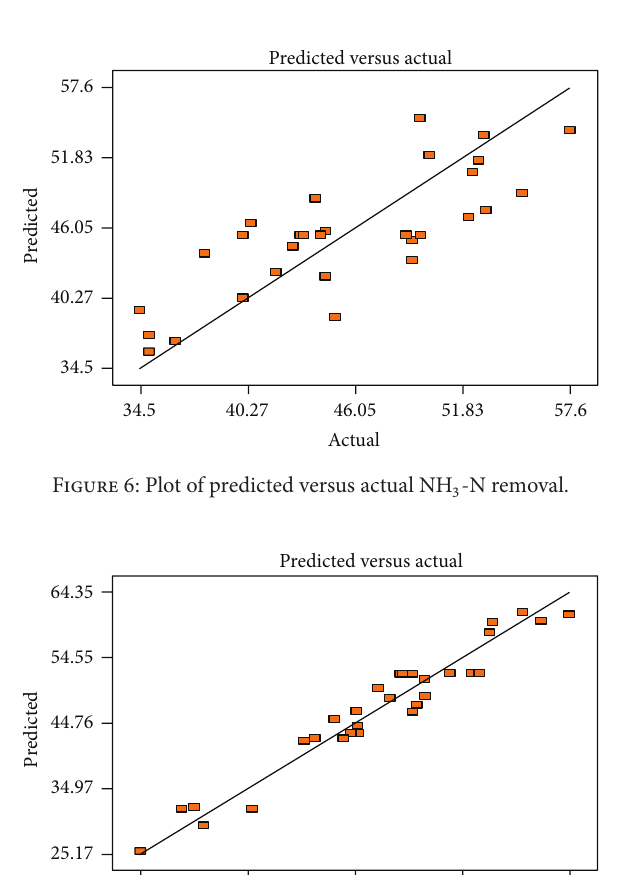
treated pesticide aqueous solution was amenable to biological treatment [33].